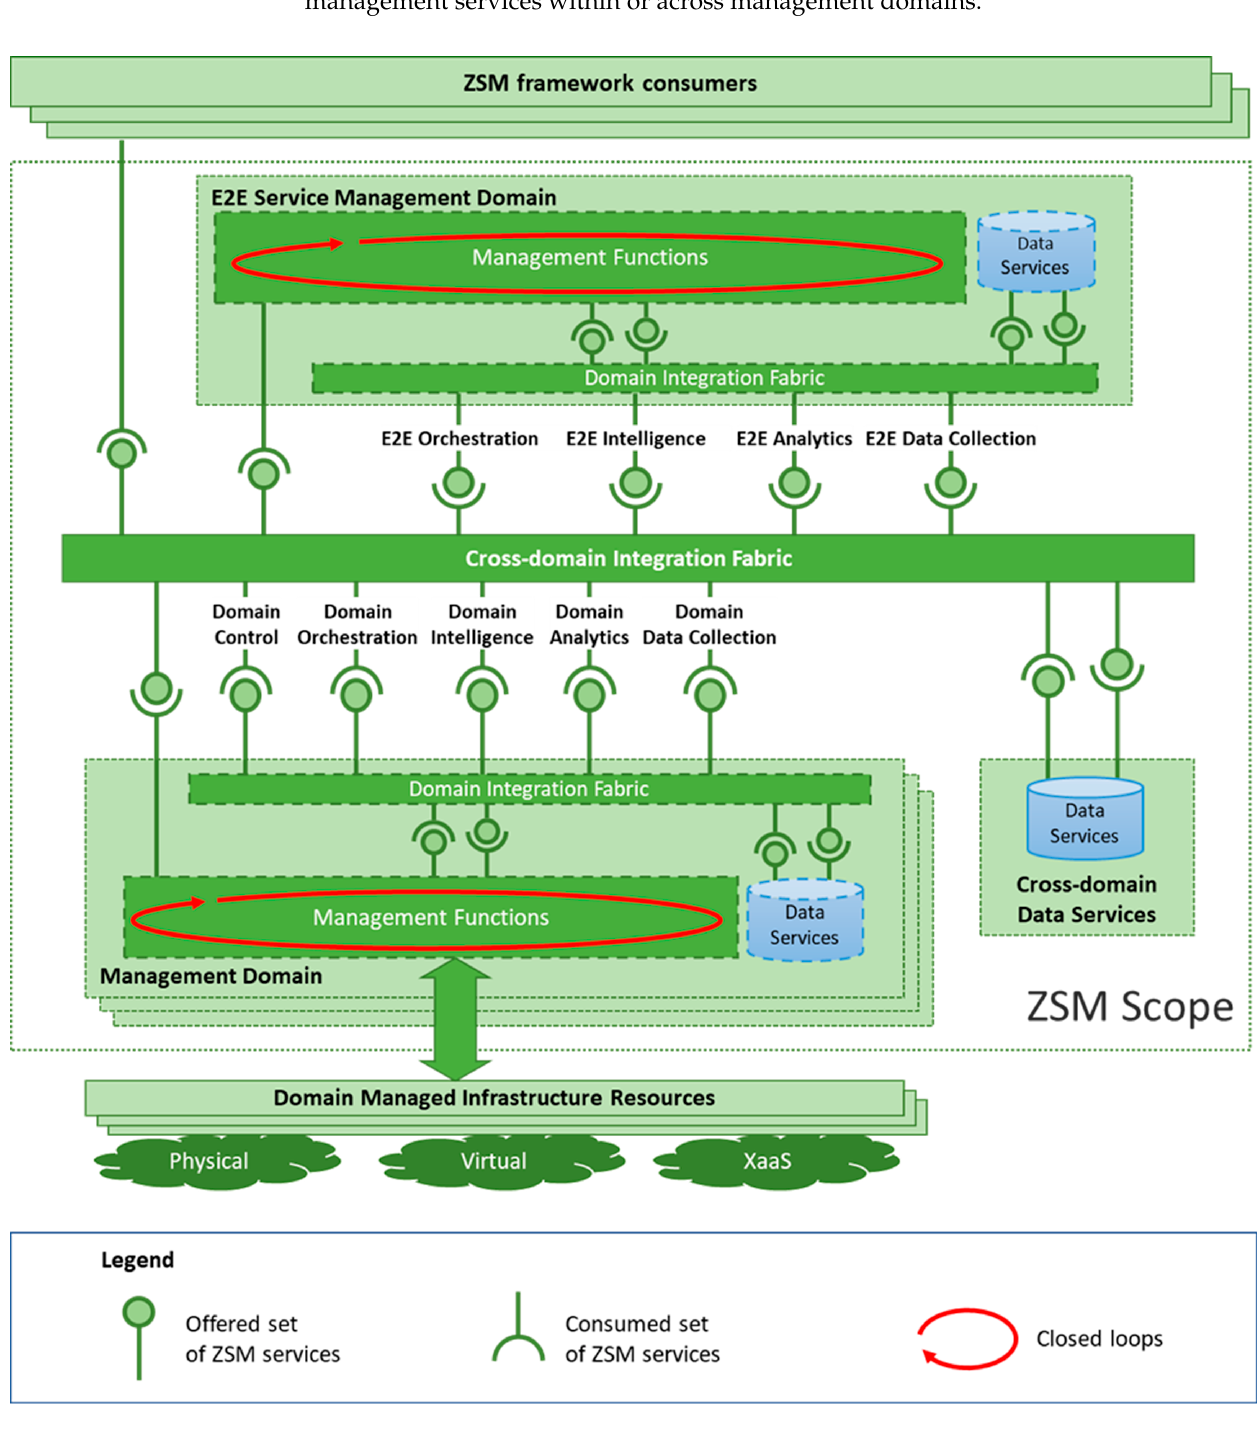
Figure 1. The ZSM architecture [34].